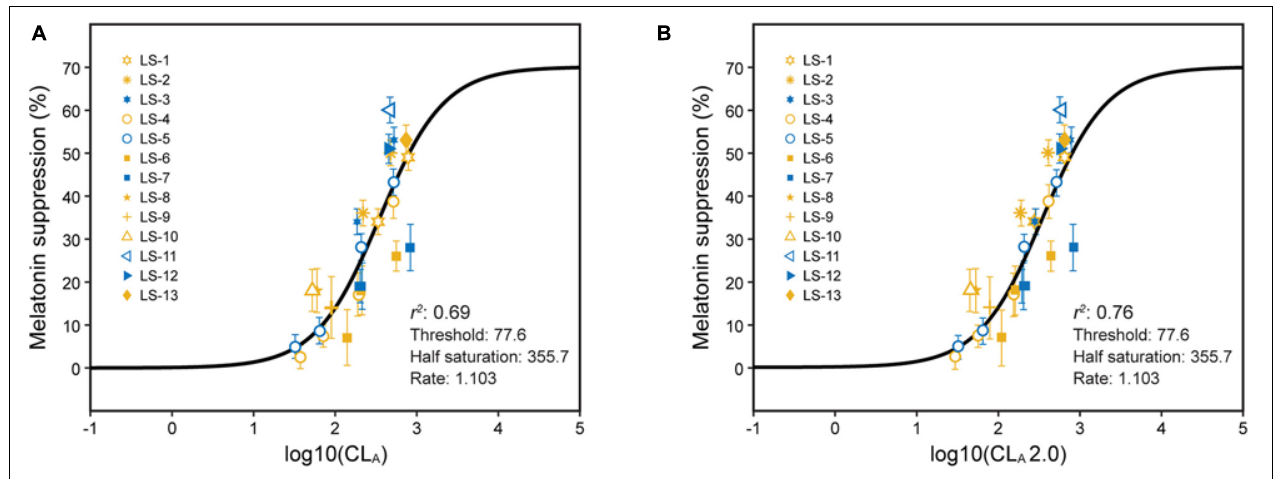
FIGURE 3 | Predictions of absolute melatonin suppression for 1-h exposures to polychromatic sources from Eqs. 1 and 2 (A) and from Eqs. 2 and 3 (B) . The legend entries correspond to the light source designations in Supplementary Table 1 and Supplementary Figure 1 . Blue symbols are associated with light sources where b-y > 0 and yellow symbols for light sources where b-y ≤ 0. It should be noted, as described in Supplementary Table 1 , the different experiments used different spatial distributions to deliver the photic